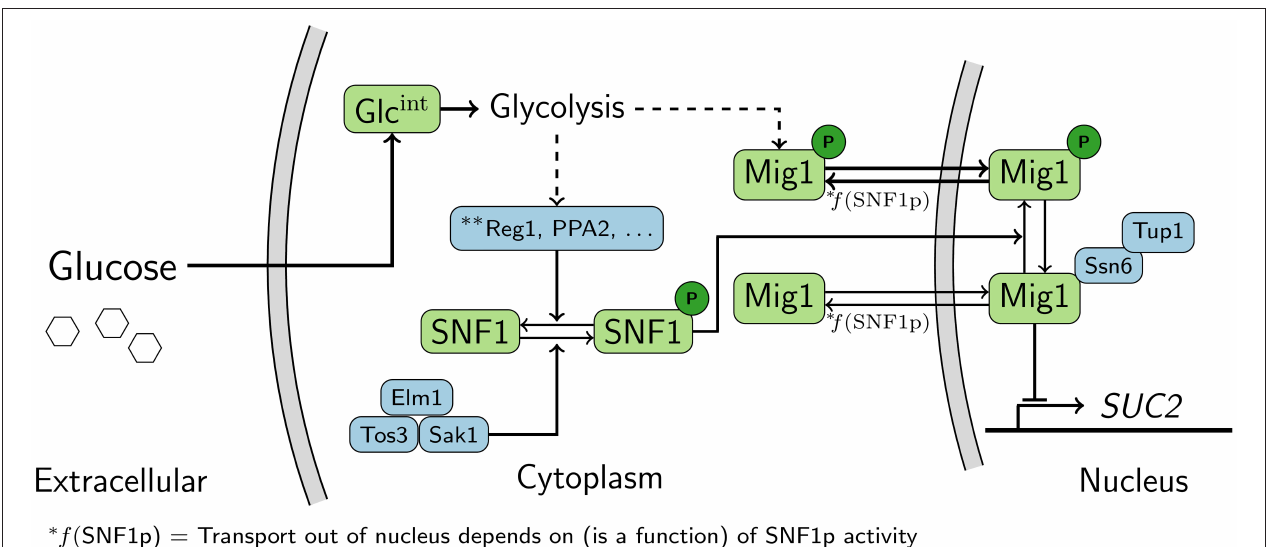
FIGURE 1 | Schematic representation of the Snf1/Mig1 pathway. Snf1 is constitutively phosphorylated by the upstream kinases. When preferred carbon-sources are limited Snf1 phosphorylates Mig1, which results in the cytoplasmic localization of Mig1. When preferred carbon sources are available Snf1 and Mig1 are dephosphorylated through an unknown mechanism originating from glycolysis. Mig1 localizes to the nucleus and there it represses genes which are required for the utilization of non-fermentable carbon-sources. Dashed arrows represent signals that are transmitted via unknown